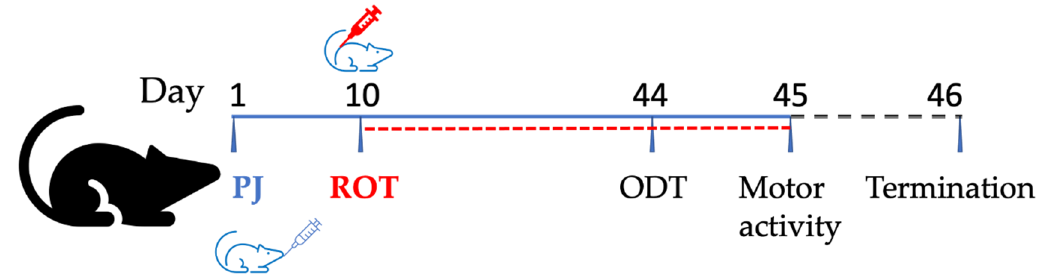
Figure 1 . Graphical presentation of the experimental design used in the study